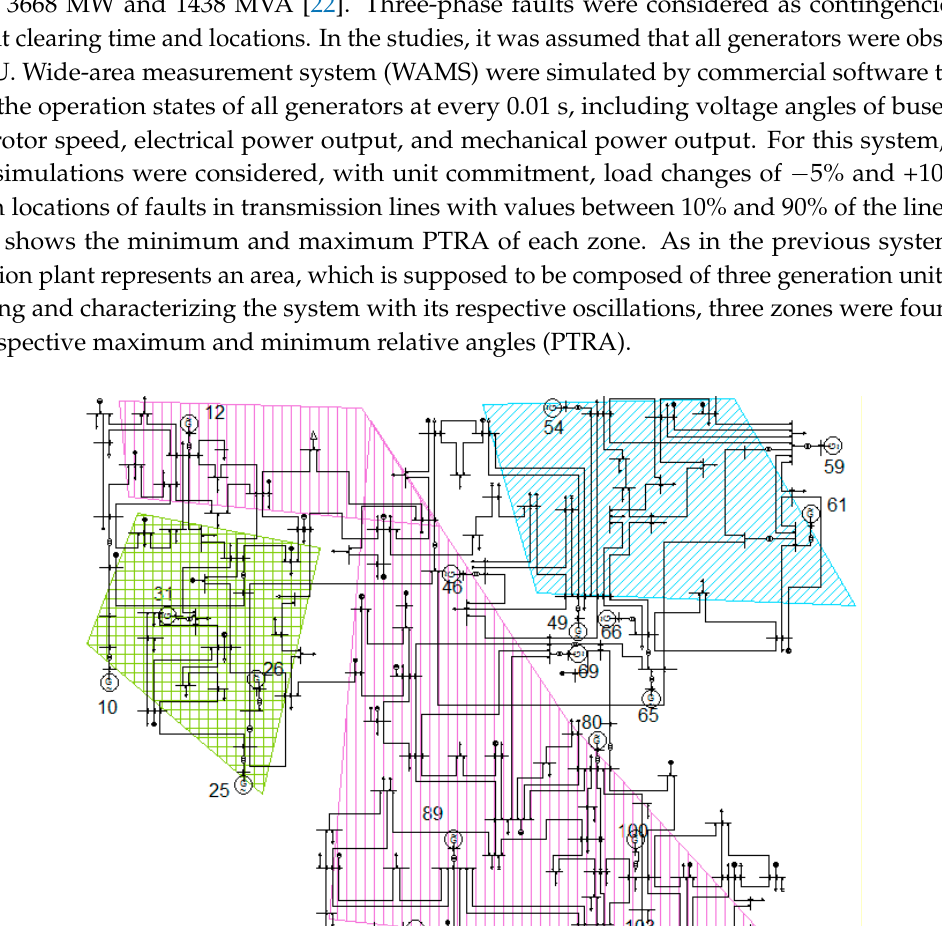
Figure 10. IEEE 118-bus power system [22].